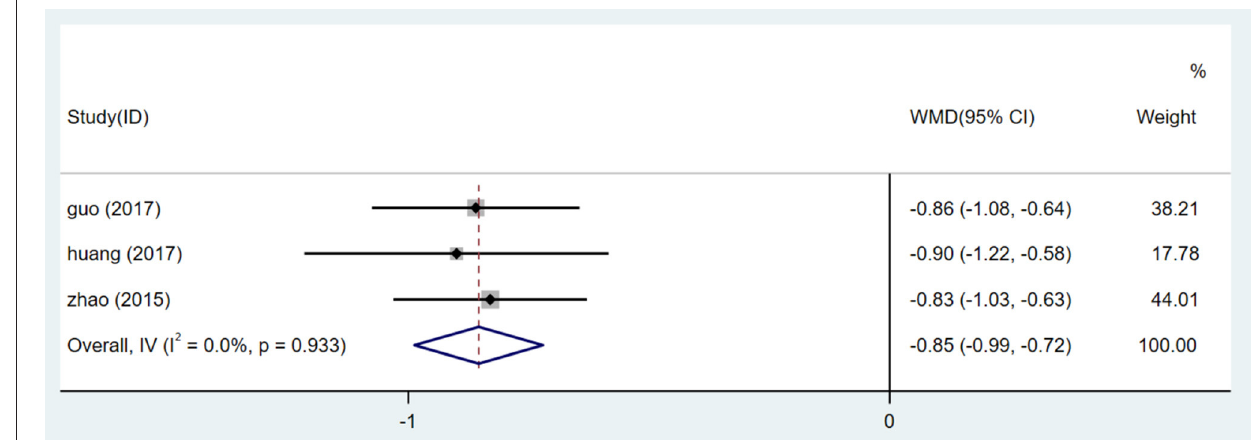
FIGURE 13 | Forest plot of Cys-c.